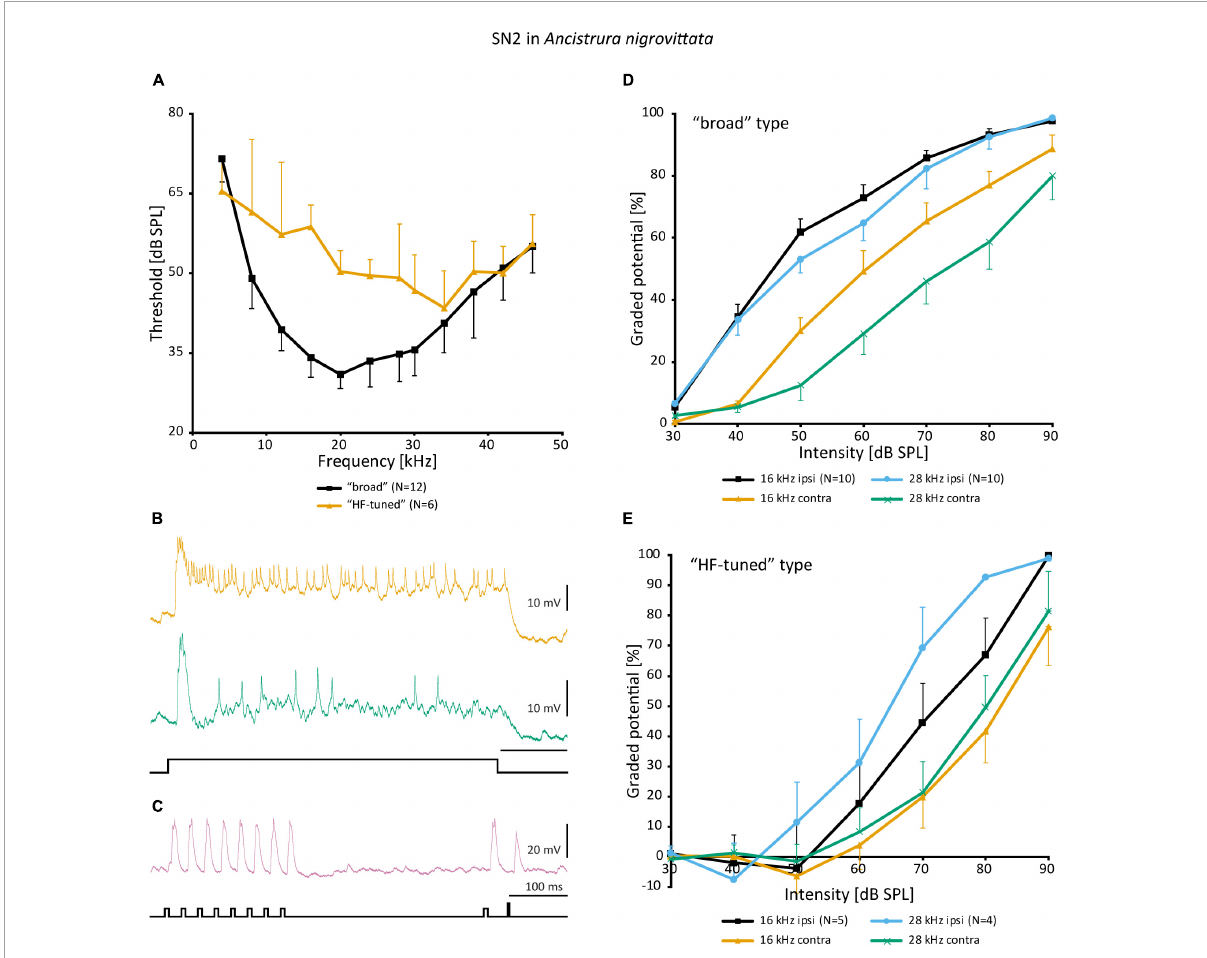
FIGURE7 Physiology of SN2 in A. nigrovittata . (A) Frequency tuning (mean ± SD) of “broad” (black; 8 females, 4 males) and “HF-tuned” SN2 (orange; 3 f, 3 m). (B) Response patterns of two SN2 in males to a 500 ms white noise stimulus of 70 dB SPL. Upper trace from a “broad”, lower from an “HF-tuned” neuron. (C) Response of a “broad” SN2 to an artificial duet between a male (smaller pulses, 16 kHz) and a female (larger single pulse, 28 kHz) at 60 dB SPL. (D,E) Intensity response curves for soma-ipsilateral (ipsi) and soma-contralateral (contra) 100 ms stimuli at 16 and 28 kHz (mean ± SEM). (D) “Broad” neurons (6 f, 4 m). (E) “HF-tuned” neurons (16 kHz: 3f, 2m; 28 kHZ: 3f, 1